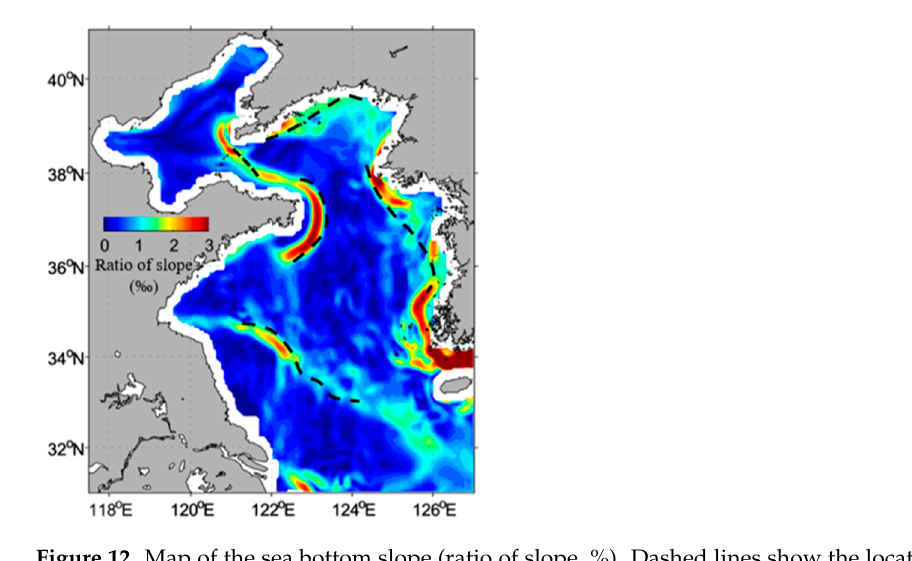
Figure 12. Map of the sea bottom slope (ratio of slope, %). Dashed lines show the location of five chl-a fronts.